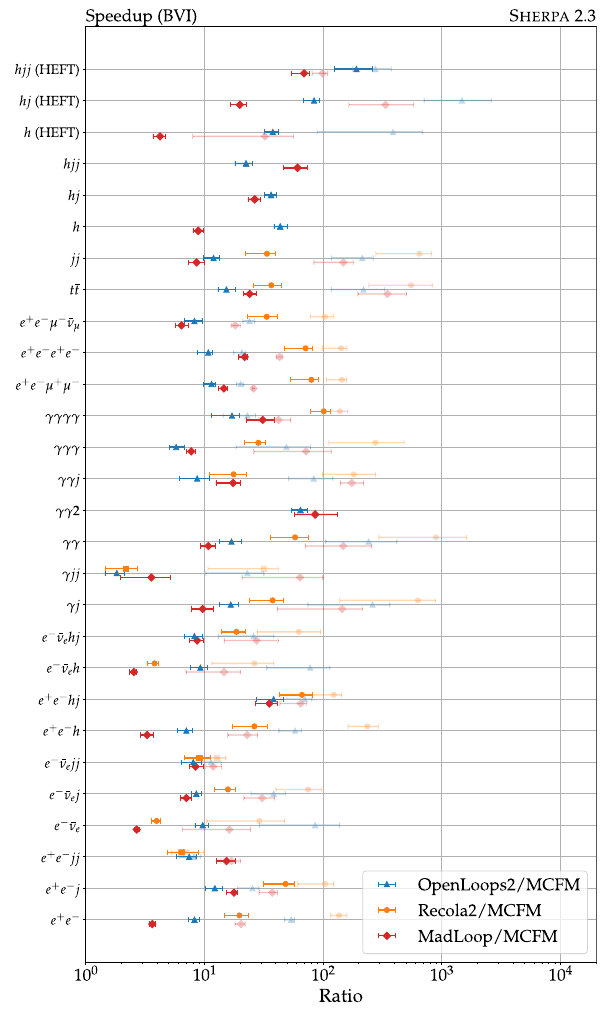
Fig. 2 CPU time ratio of O PEN L OOPS 2, R ECOLA 2 5 , and M AD L OOP 5 toM CFM atthelevelofBorn-likecontributionstotheNLOcrosssection (BVI)